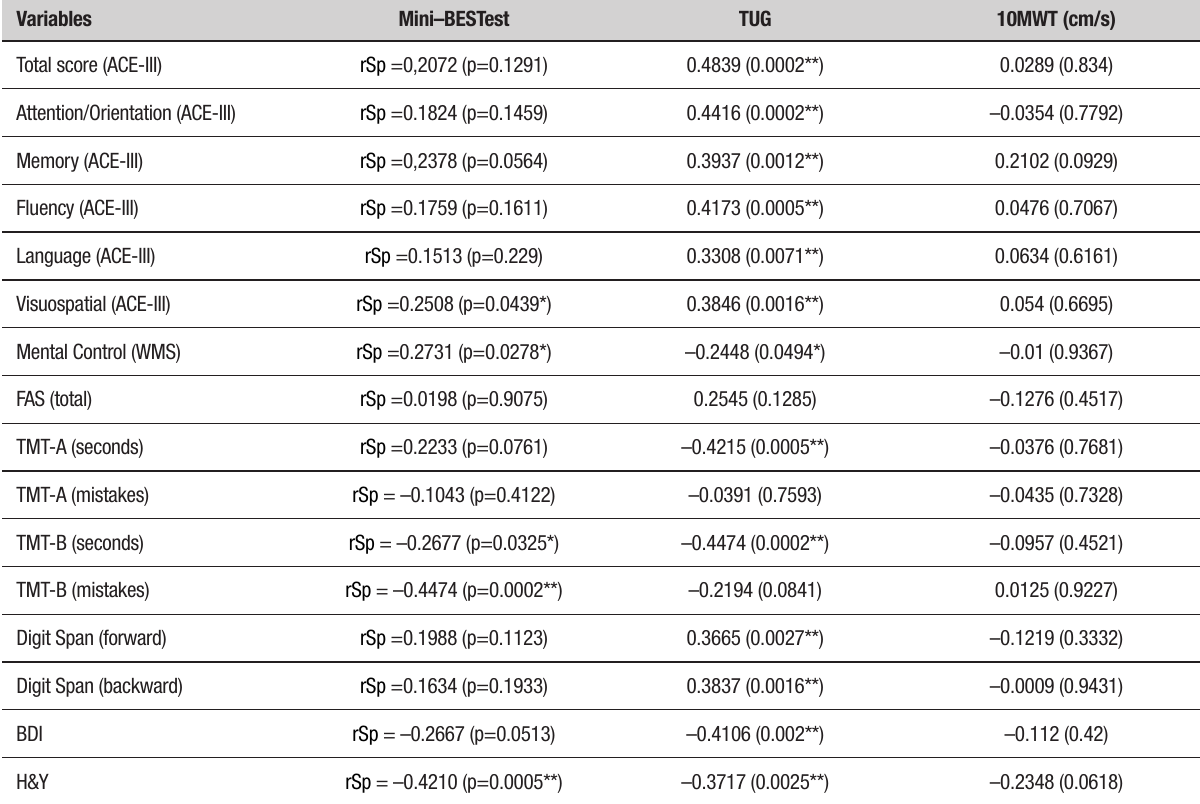
Table 2. Correlation between cognitive and motor variables.